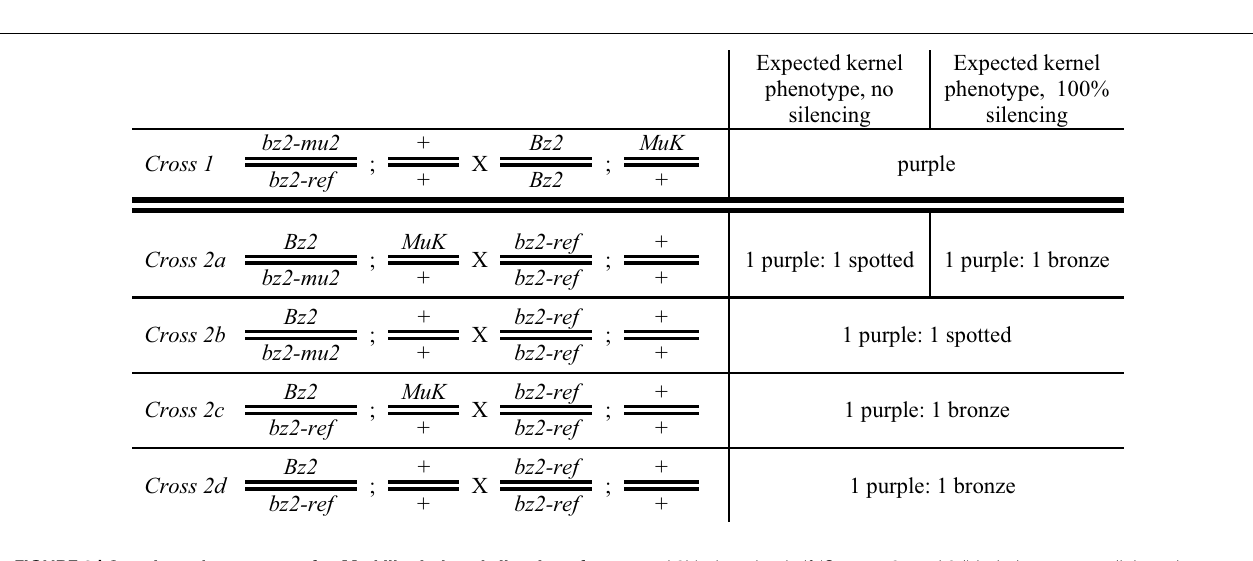
and 2b); the other half (Crosses 2c and 2d) lack the reporter allele and are expected to segregate 1:1 purple:bronze. Mu killer is segregating 1:1 in Crosses 2a and